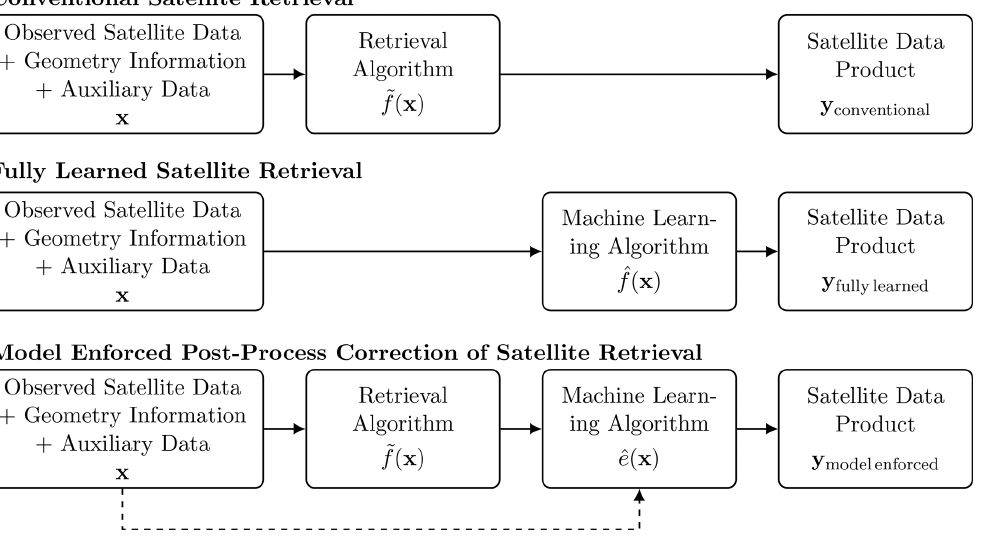
Figure 1. Top: conventional satellite retrieval. Middle: fully learned machine-learning-based satellite retrieval approach. Bottom: model- enforced post-process correction of satellite retrieval approach.